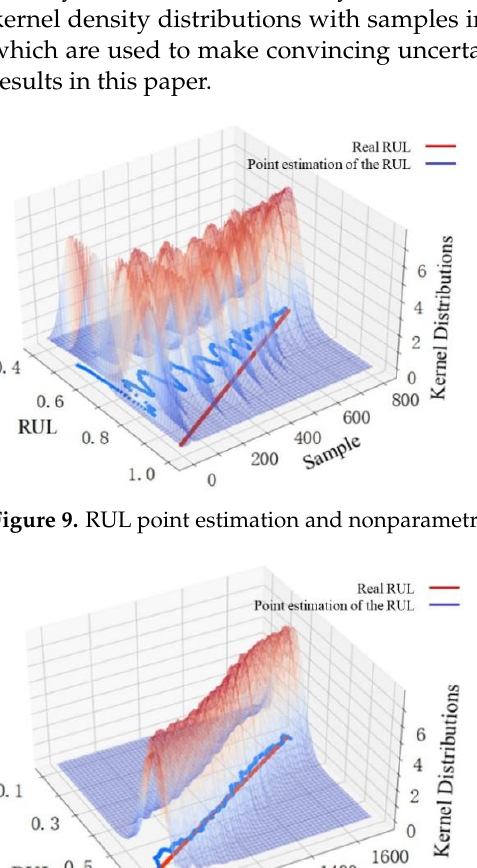
Figure 8. Distribution range of each sample point with a 95% confidence interval.